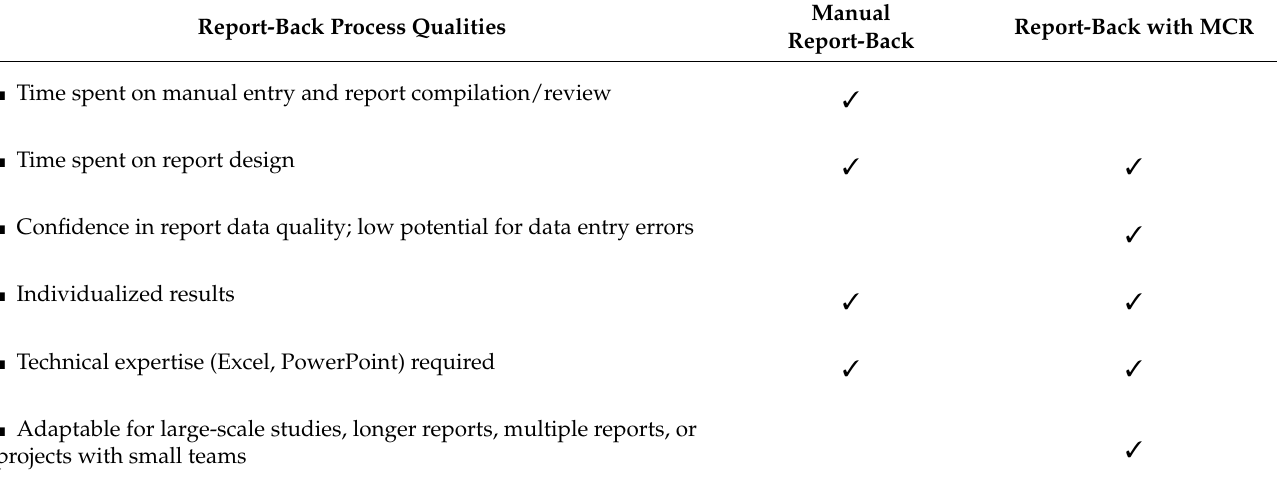
Table 3. Report-back process qualities for manual reporting and reporting with MCR. Report-Back Process Qualities